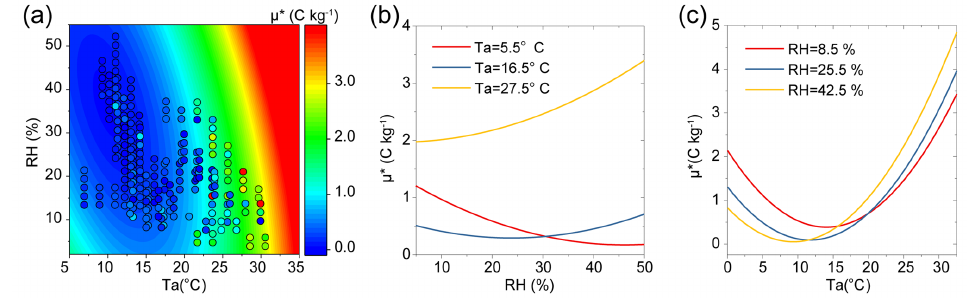
Figure 5. Dependence of the µ ∗ on environmental factors. (a) Comparison of the MLR model (contour) with measurement-based data (cir- cle). (b) The predicted µ ∗ as a function of RH for different ambient temperatures. (c) The predicted µ ∗ as a function of ambient temperature for different